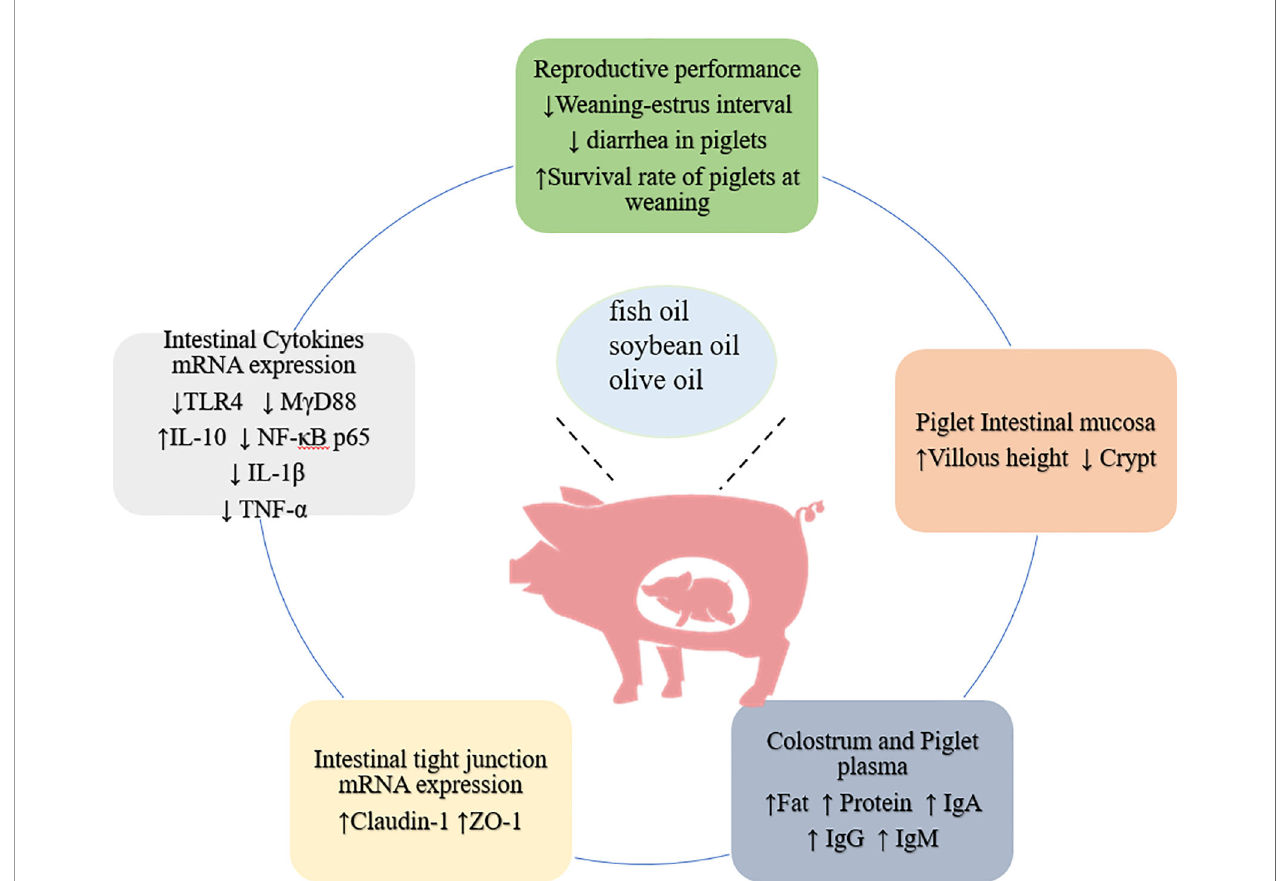
FIGURE 2 | Bene fi cial effects of adding fat in feed of pregnant sow on